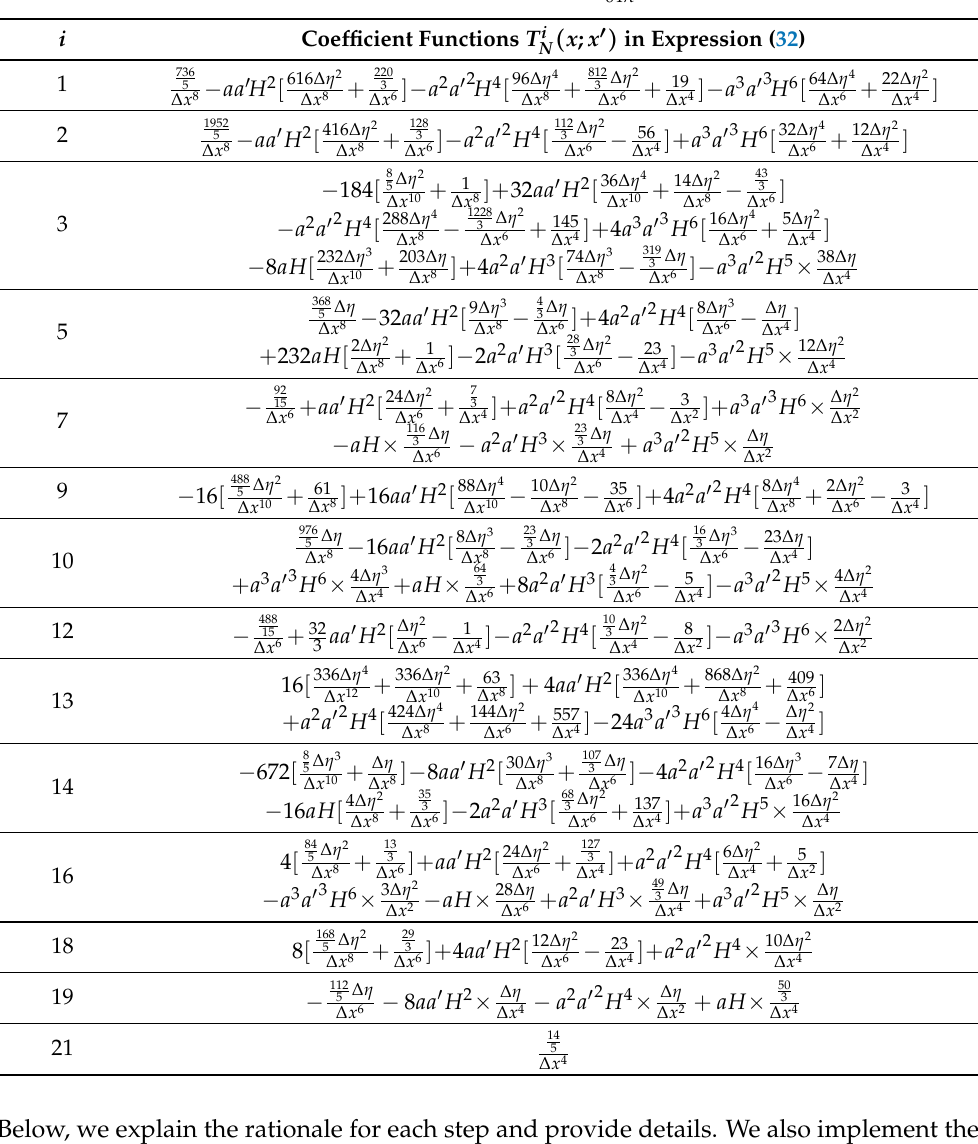
κ 2 . 64 π 4 − ( x ; x (cid:48) ) in Expression N